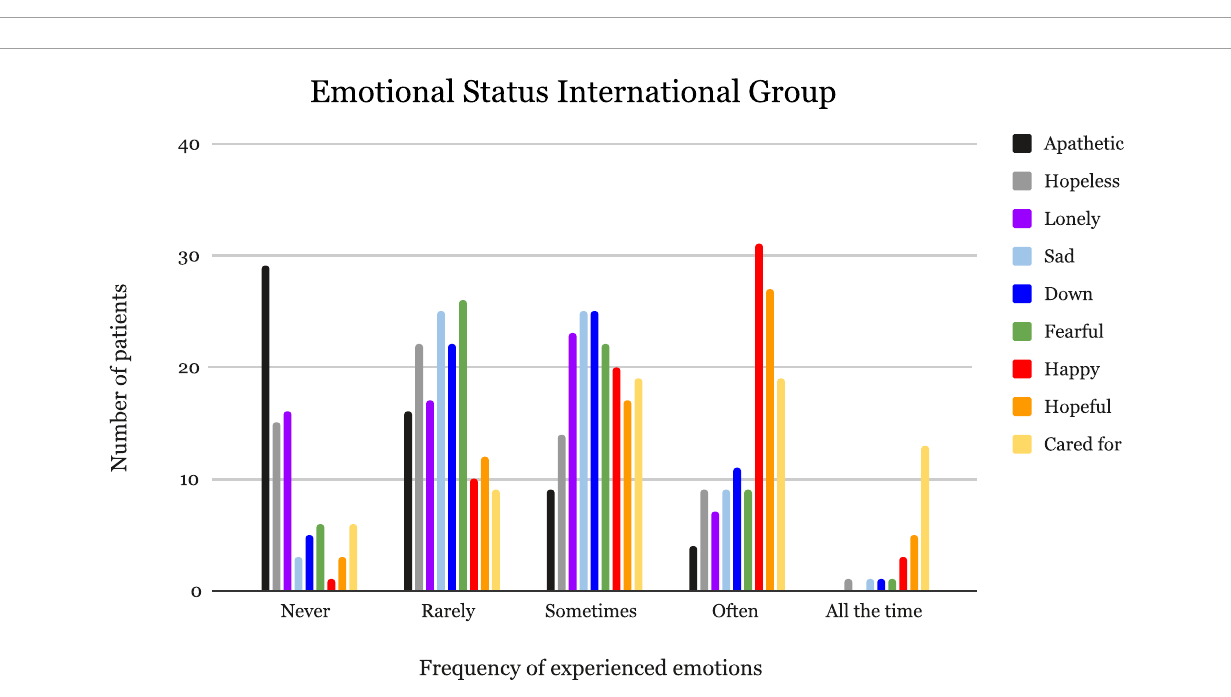
group (68.1%) and the international group (72.9%) were worried about having